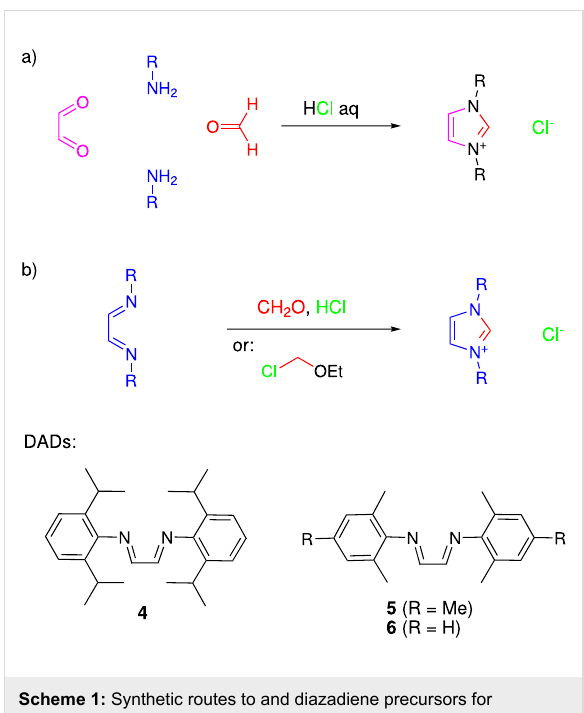
Scheme 1: Synthetic routes to and diazadiene precursors for imidazolium